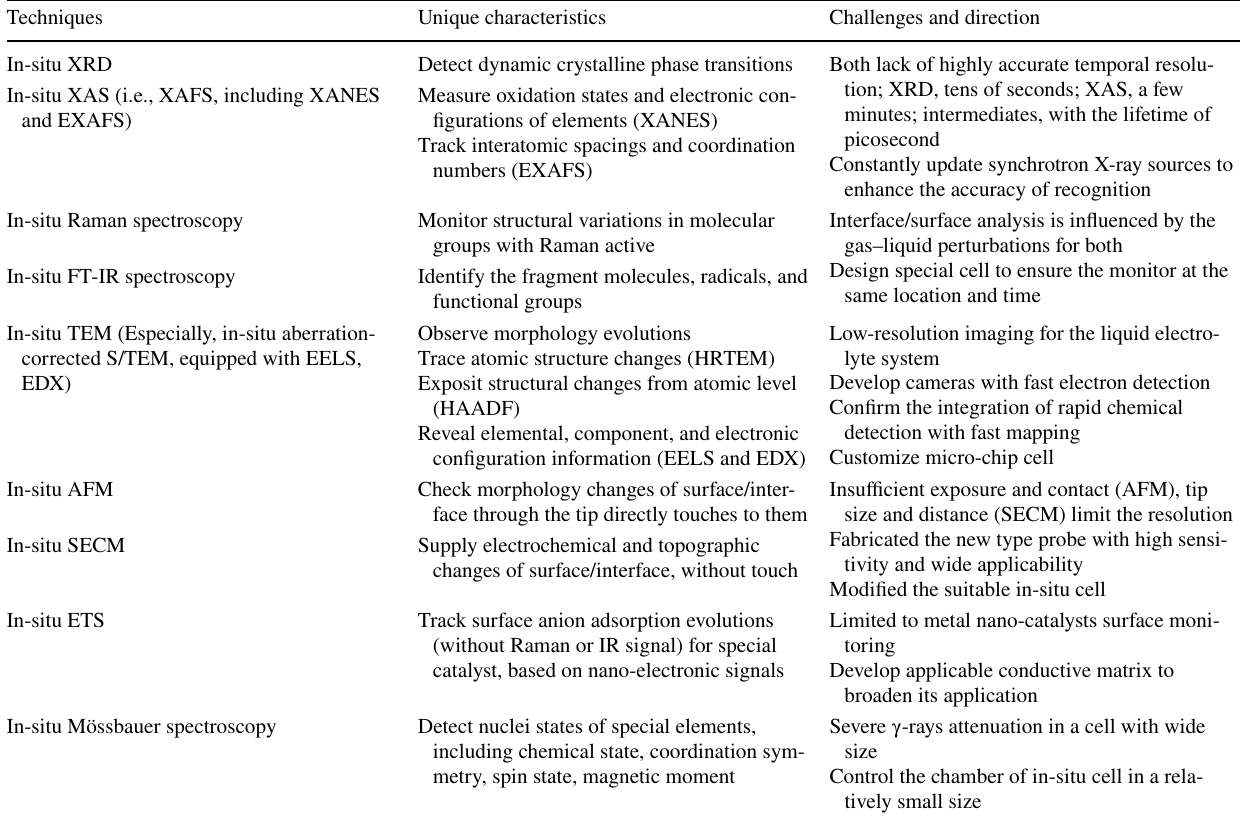
Table 1 Unique characteristics, challenges, and improvement direction of different in-situ techniques